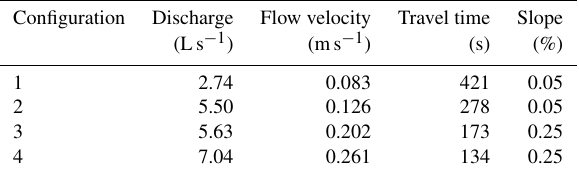
Table 2. Summary of the configuration set-up used at the EcoCatch flumes of the Lunz Mesocosm